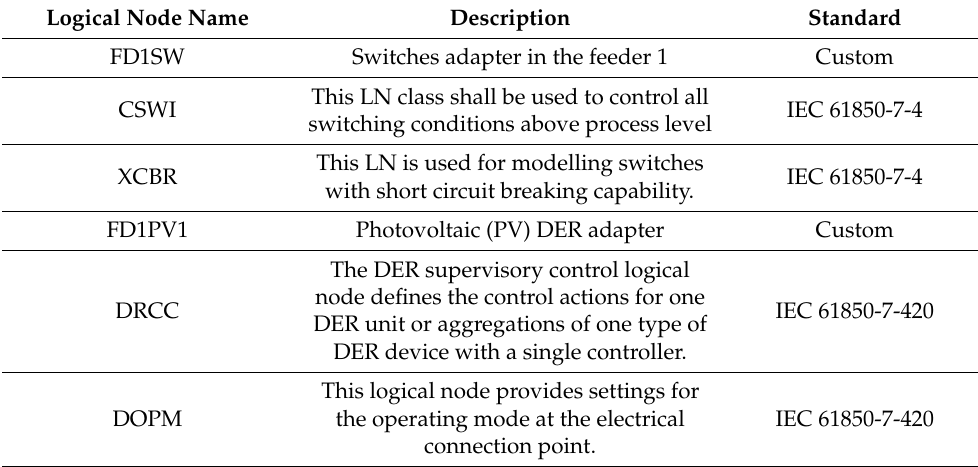
Table 1. Logical nodes for Figure